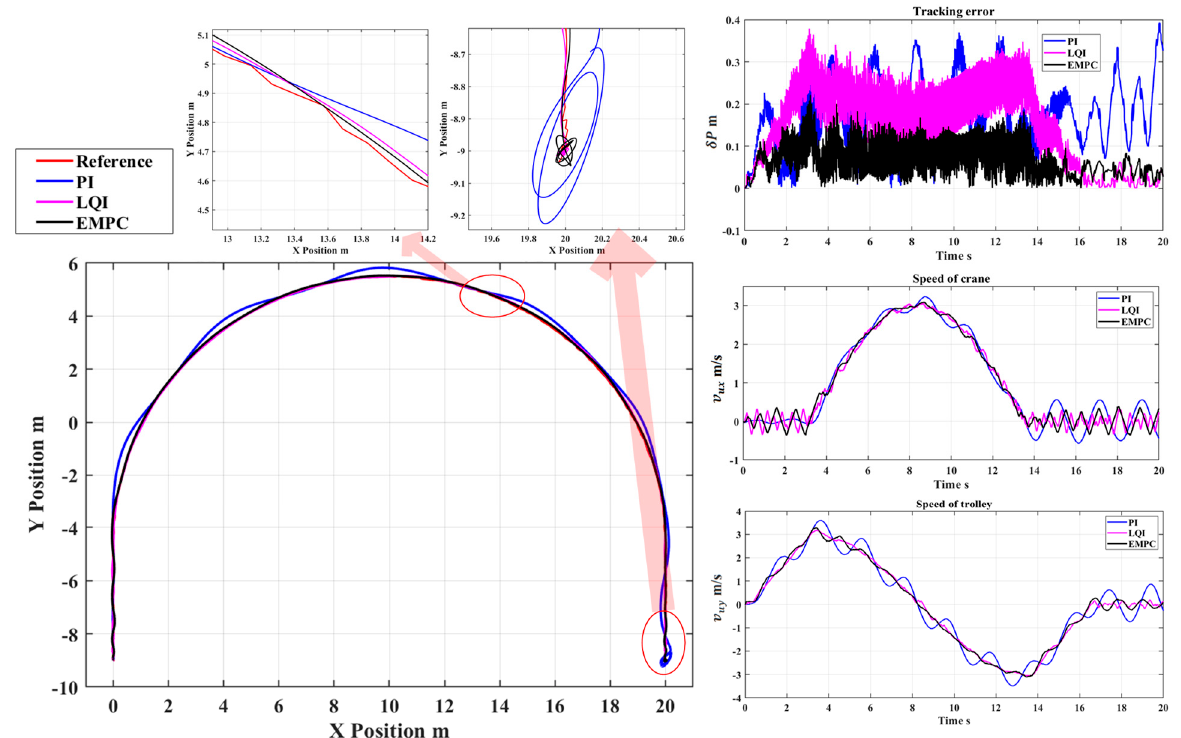
Figure 11. The results of tracking desired path three by the crane and trolley are presented. The figures illustrate the following outcomes: a comparison between the trajectory of the upper lifting point and the expected trajectory under three different controllers, the tracking error δ P = (cid:3495)𝛿𝑃 (cid:3051)(cid:2870) + 𝛿𝑃 (cid:3052)(cid:2870) of the track-following servo subsystem, and the movement speed of both the crane and trolley.